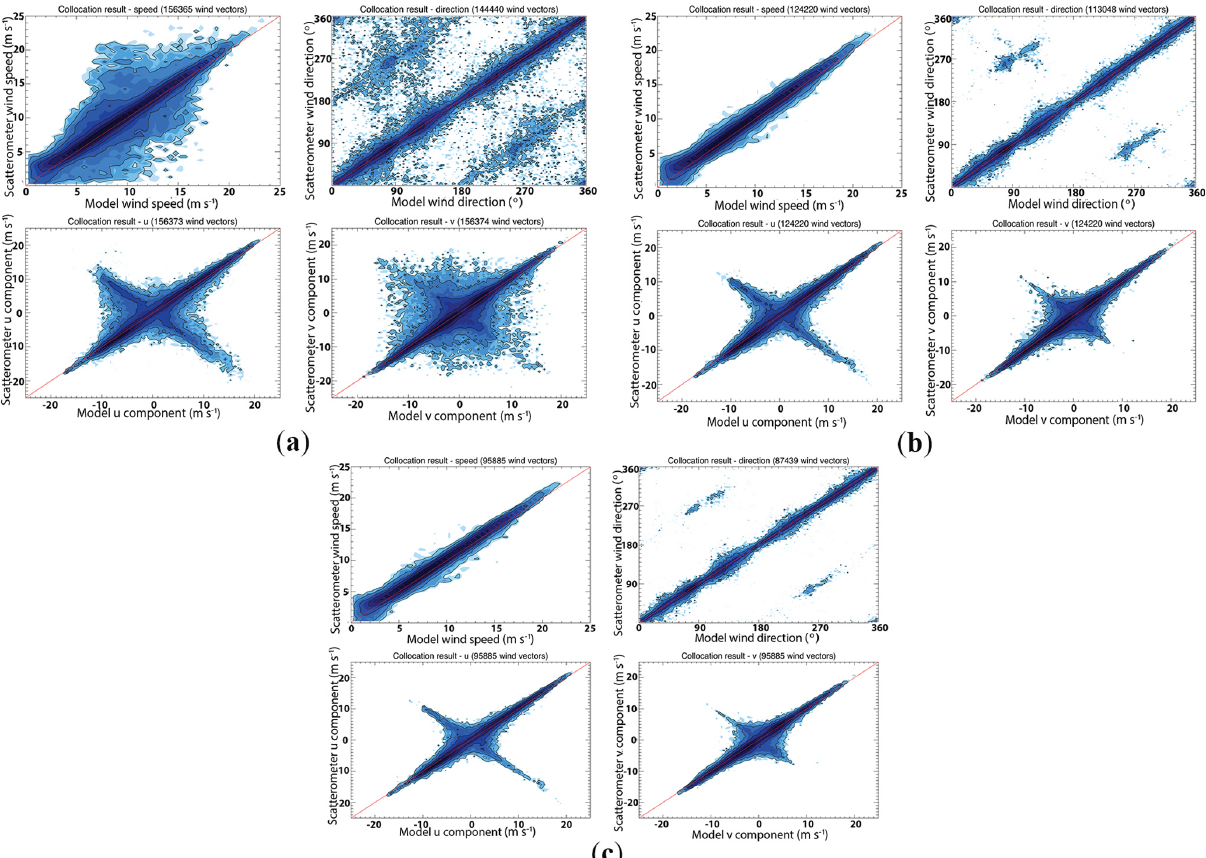
Figure 17. Contoured histograms of SCAT-retrieved first rank wind solution versus input wind field for four orbits. (a) All WVCs within the swath; (b) excluding the WVCs in the outer swath, for which WVC numbers from 8 to 42 are included; (c) excluding the WVCs in the outer swath and nadir swath, for which WVC numbers from 8 to 17 and 26 to 42 are included. From (a) to (c) , upper left: wind speed; upper right: wind direction; lower left: u component; lower right: v component. The contour lines are